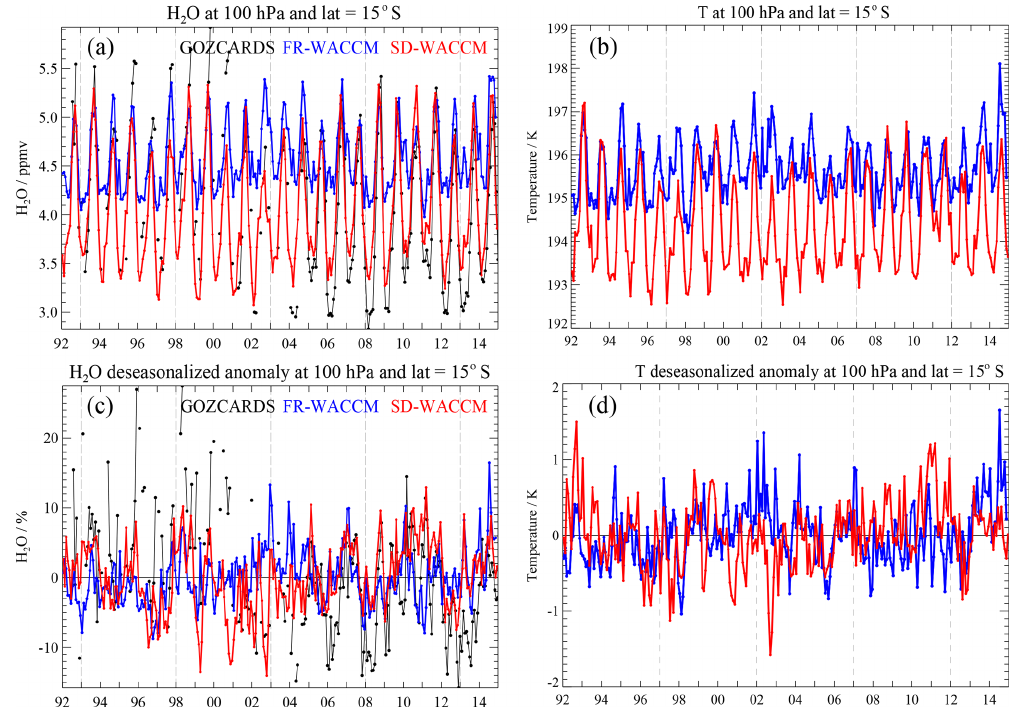
Figure 16. Time series (1992–2014) at 100hPa and 10–20 ◦ S for temperature (b, d) and H 2 O (a, c) , with deseasonalized anomalies shown in (c, d) . The temperature plots just show the two models (FR-WACCM in blue, SD-WACCM in red), whereas the H 2 O series show the comparisons for the models versus GOZCARDS merged H 2 O data (in